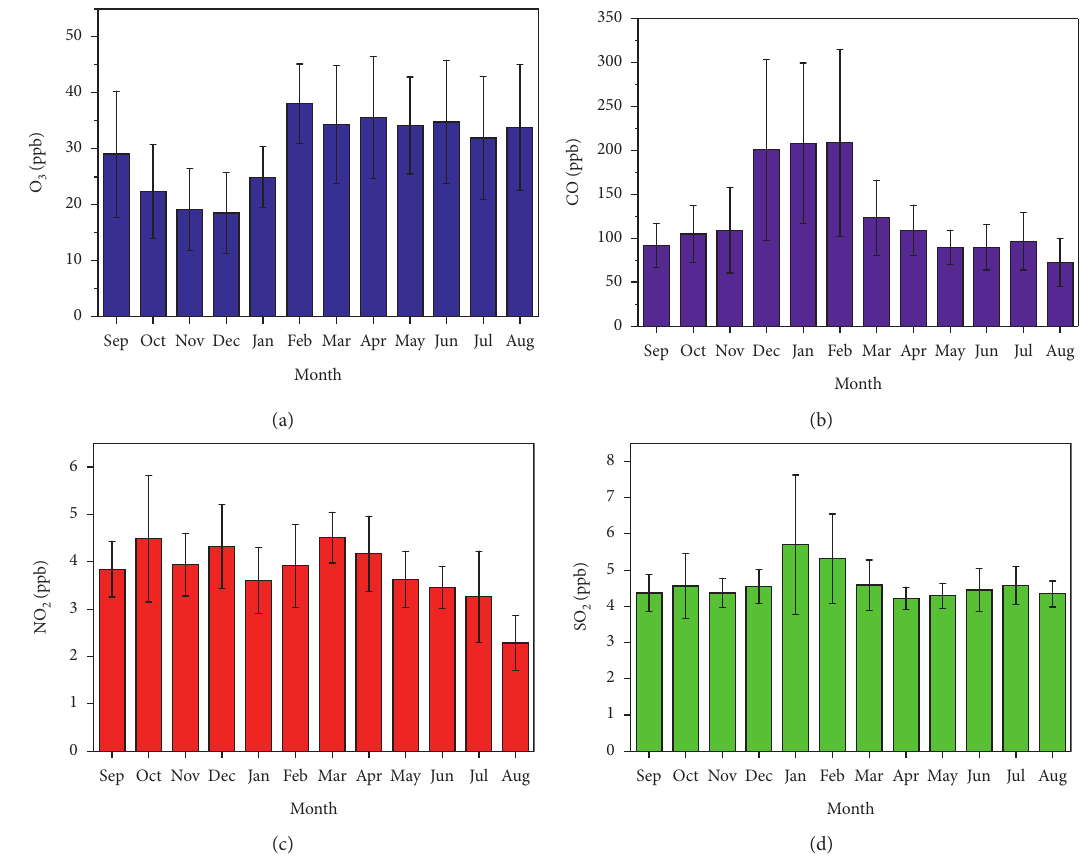
Figure 3: Monthly statistical results of the mean hourly mixing ratios of O